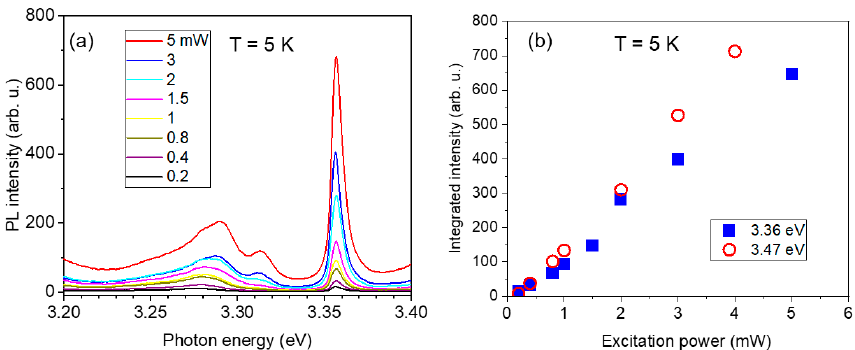
Figure 3. ( a ) Time-integrated PL spectra taken at 5 K at different excitation powers for the hybrid Ag NPs/GaN NW structure. Spectra are shown in the region around the 3.36 eV line. ( b ) Integrated PL intensity measured at 5 K for the 3.36 eV line (closed squares) and for the 3.47 eV DBE emission (open circles) vs excitation power.